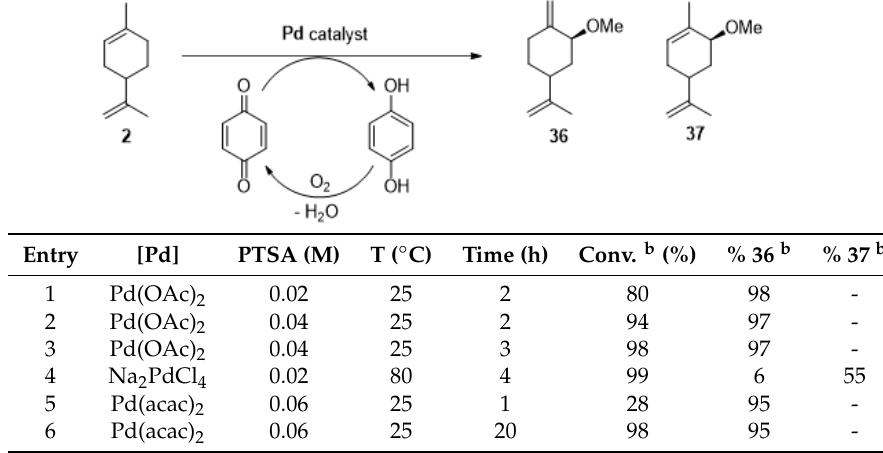
Table 14. Palladium-catalyzed oxidation of α -bisabolol 38 with molecular oxygen in the presence of benzoquinone and copper acetate a (adapted from reference